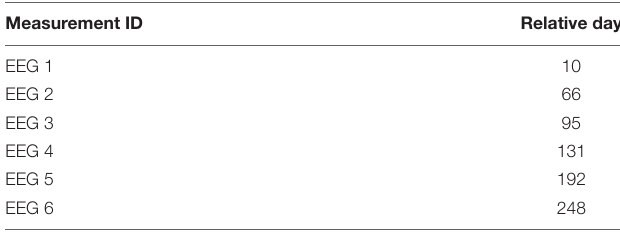
TABLE 2 | Chronological information about subsequent EEG